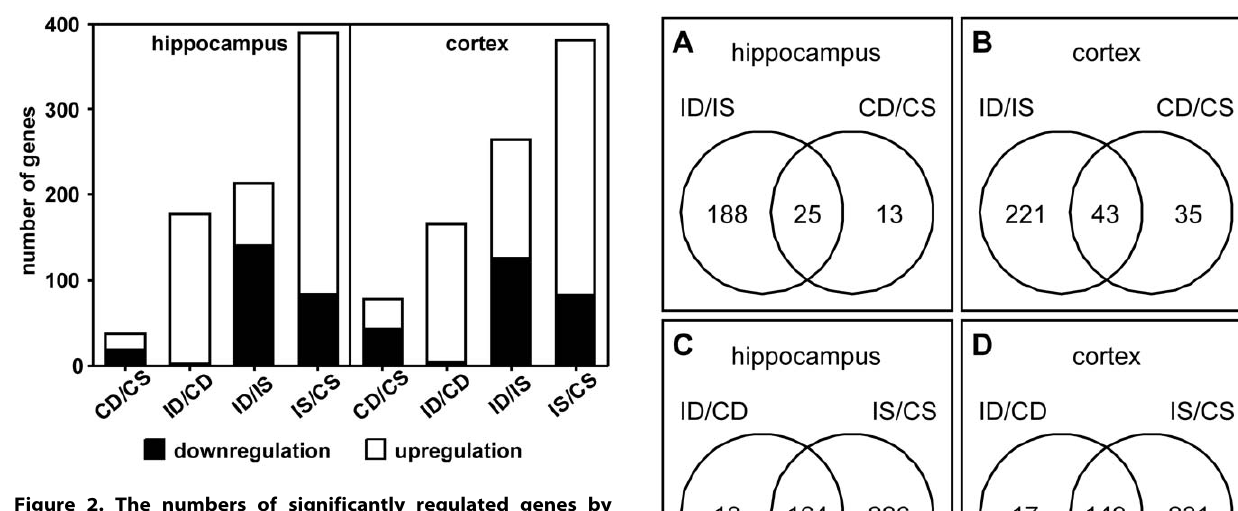
Figure 2. The numbers of significantly regulated genes by comparing the different treatment groups. C=control animals, D=dexamethasone treatment, S=saline treatment, I=infected animals.